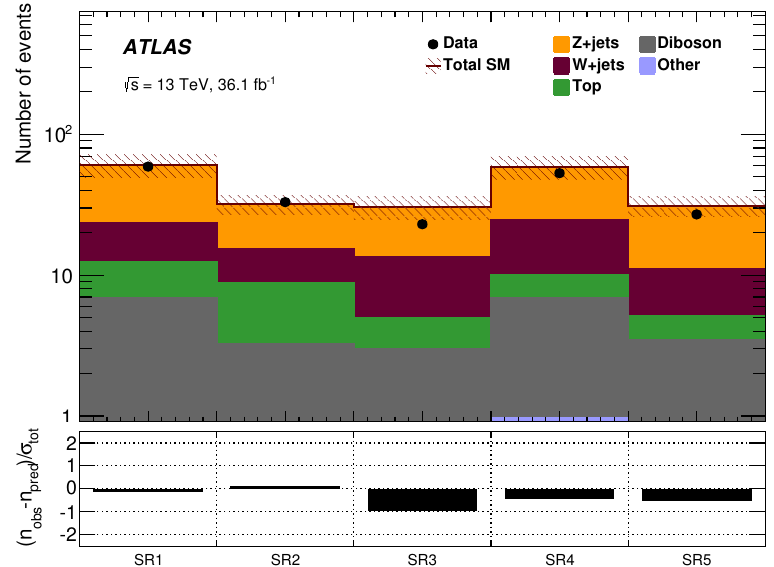
Figure 4 . Comparison of the numbers of data events and predicted SM yields in each signal region. The normalisation of the backgrounds is obtained from the (cid:12)t to the CRs. The shaded band indicates the total background uncertainty. The lower panel shows the pulls, estimated as the di(cid:11)erence between the observed number of events ( n obs ) and the predicted background yields ( n pred ) divided by the total uncertainty ( (cid:27) tot